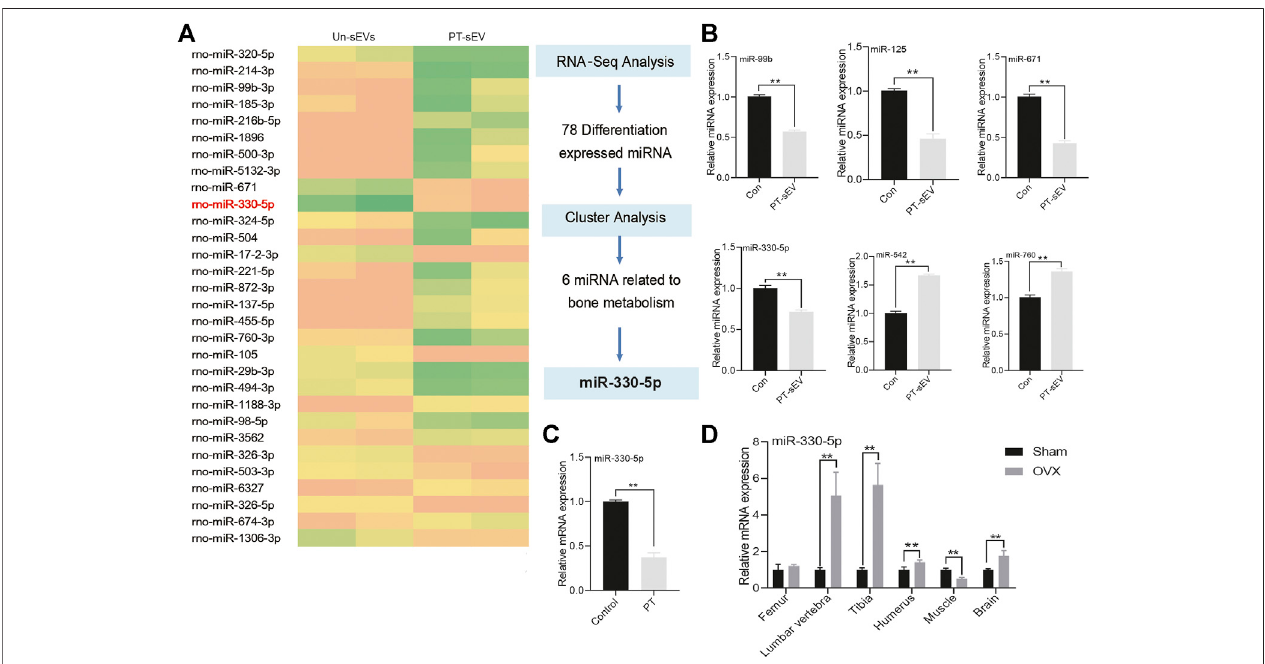
FIGURE5| ThemiRNApro fi leofPT-sEV. (A) TheheatmapofdifferentiallyexpressedmiRNA; (B) qPCRveri fi edthesedifferentiallyexpressedmiRNAinthedifferent group, the normalized data represented the mean ± SD; (C) The miR-330 – 5p expression under the treatment of PT in BMSCs; (D) miR-330 – 5p expression at different tissues in OVX rats. The normalized data represented the mean ± SD. ** p < 0.01, analyses were done twice and obtained comparable